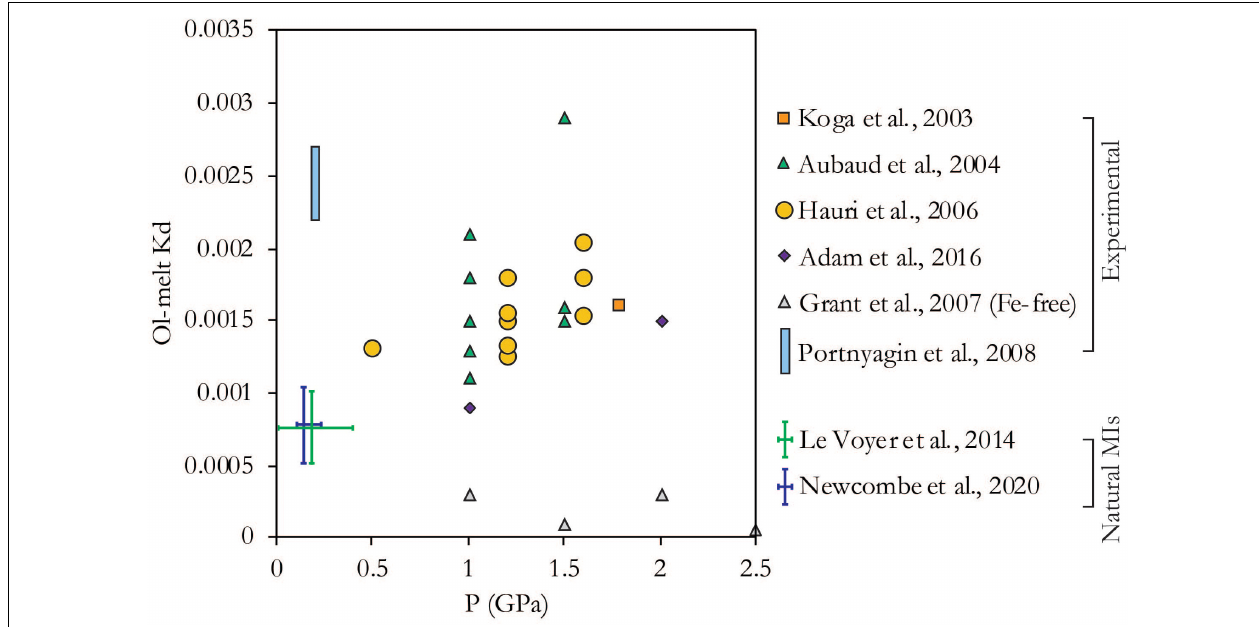
FIGURE 2 | H olivine/melt partition coefficient (K d ) from experimental studies < 3 GPa and measurements on natural MI-olivine pairs. Error bars for pressure of natural MIs shows full range of reported MI entrapment depths (Le Voyer et al., 2014: Sommata cinder cone, Vulcano = 0.1–0.2 GPa, Jorullo cinder cone = 0.01–0.4 GPa; Newcombe et al., 2020a 1959 Kilauea Iki = 0.11 GPa, Fuego = 0.25 GPa, Seguam = 0.15 MPa). Error bars for K d of natural MIs shows ± 1 sigma of measured values. Note that all studies apart from Newcombe et al., 2020a use a calibration for H 2 O in olivine from Bell et al. (2003); using the calibration from Withers et al. (2012) would decrease the partition coefficient by